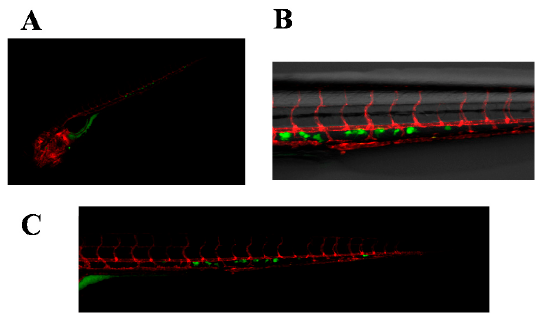
Figure 3. Images of carboxyfluorescein succinimidyl ester (CFSE)-labeled, patient-derived breast cancer bone metastasis (primary cells) xenografted in Tg ( kdrl :mcherry) ZF embryos. ( A ) Whole-body image of the zebrafish embryo at 5 dpi (25× magnification). Primary cells disseminated predominantly in the caudal hematopoietic tissues (CHT) of the embryo; ( B ) Details of ( A ), showing the interactions of primary cells with the zebrafish vessels in the CHT. Cells extravasated in the CHT of the ZF embryo and engrafted in close proximity of the vessels. Fluorescent images merged with brightfield image, 63× magnification; ( C ) Combined picture of the CHT of embryo in ( A , B ). Individual images were taken at 63× magnification.